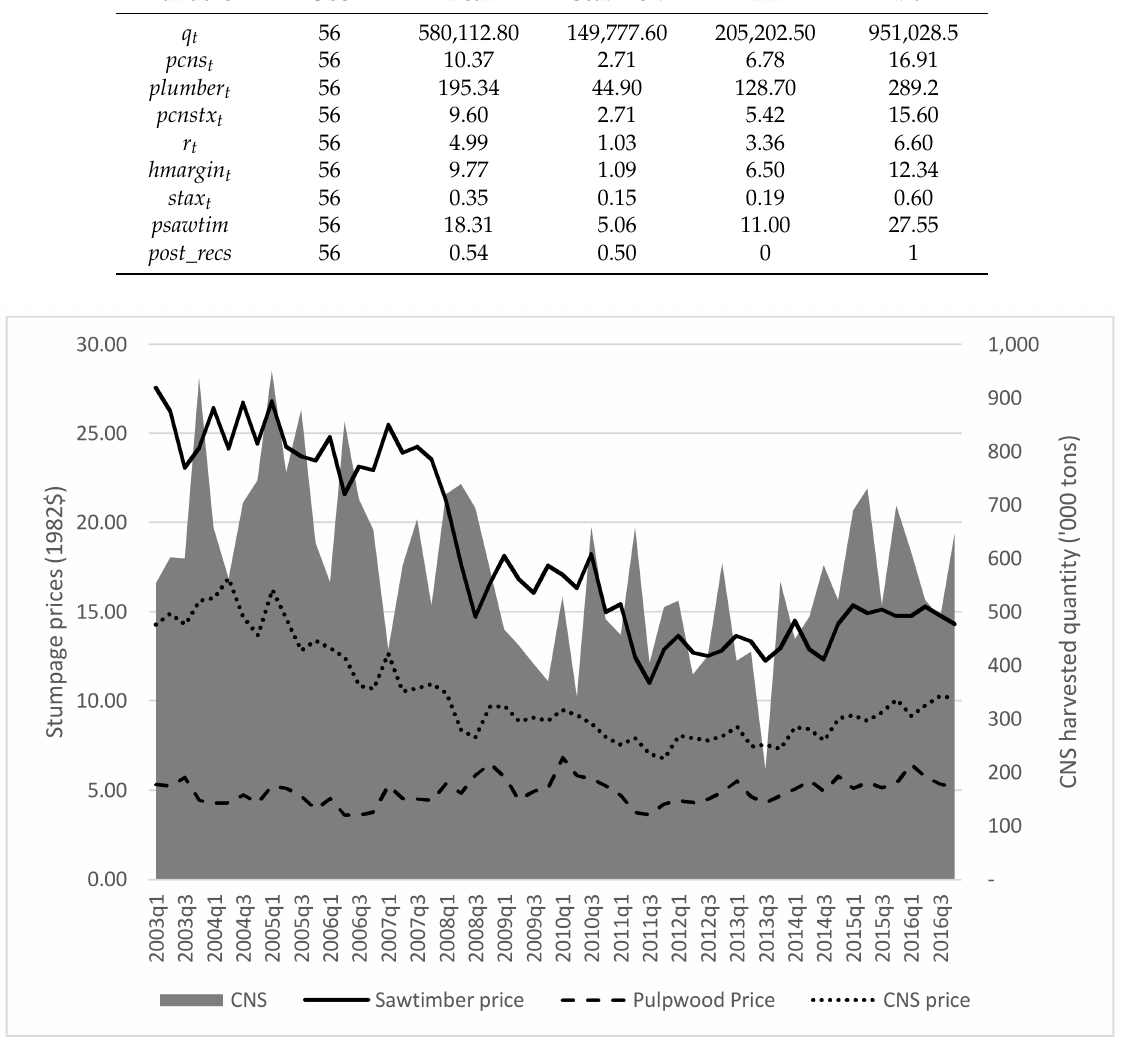
Figure 1. Quarterly chip-n-saw (CNS) harvested quantity and price series of sawtimber and chip-n-saw stumpage products in Louisiana, USA (Data sources: Louisiana Department of Revenue and Timber